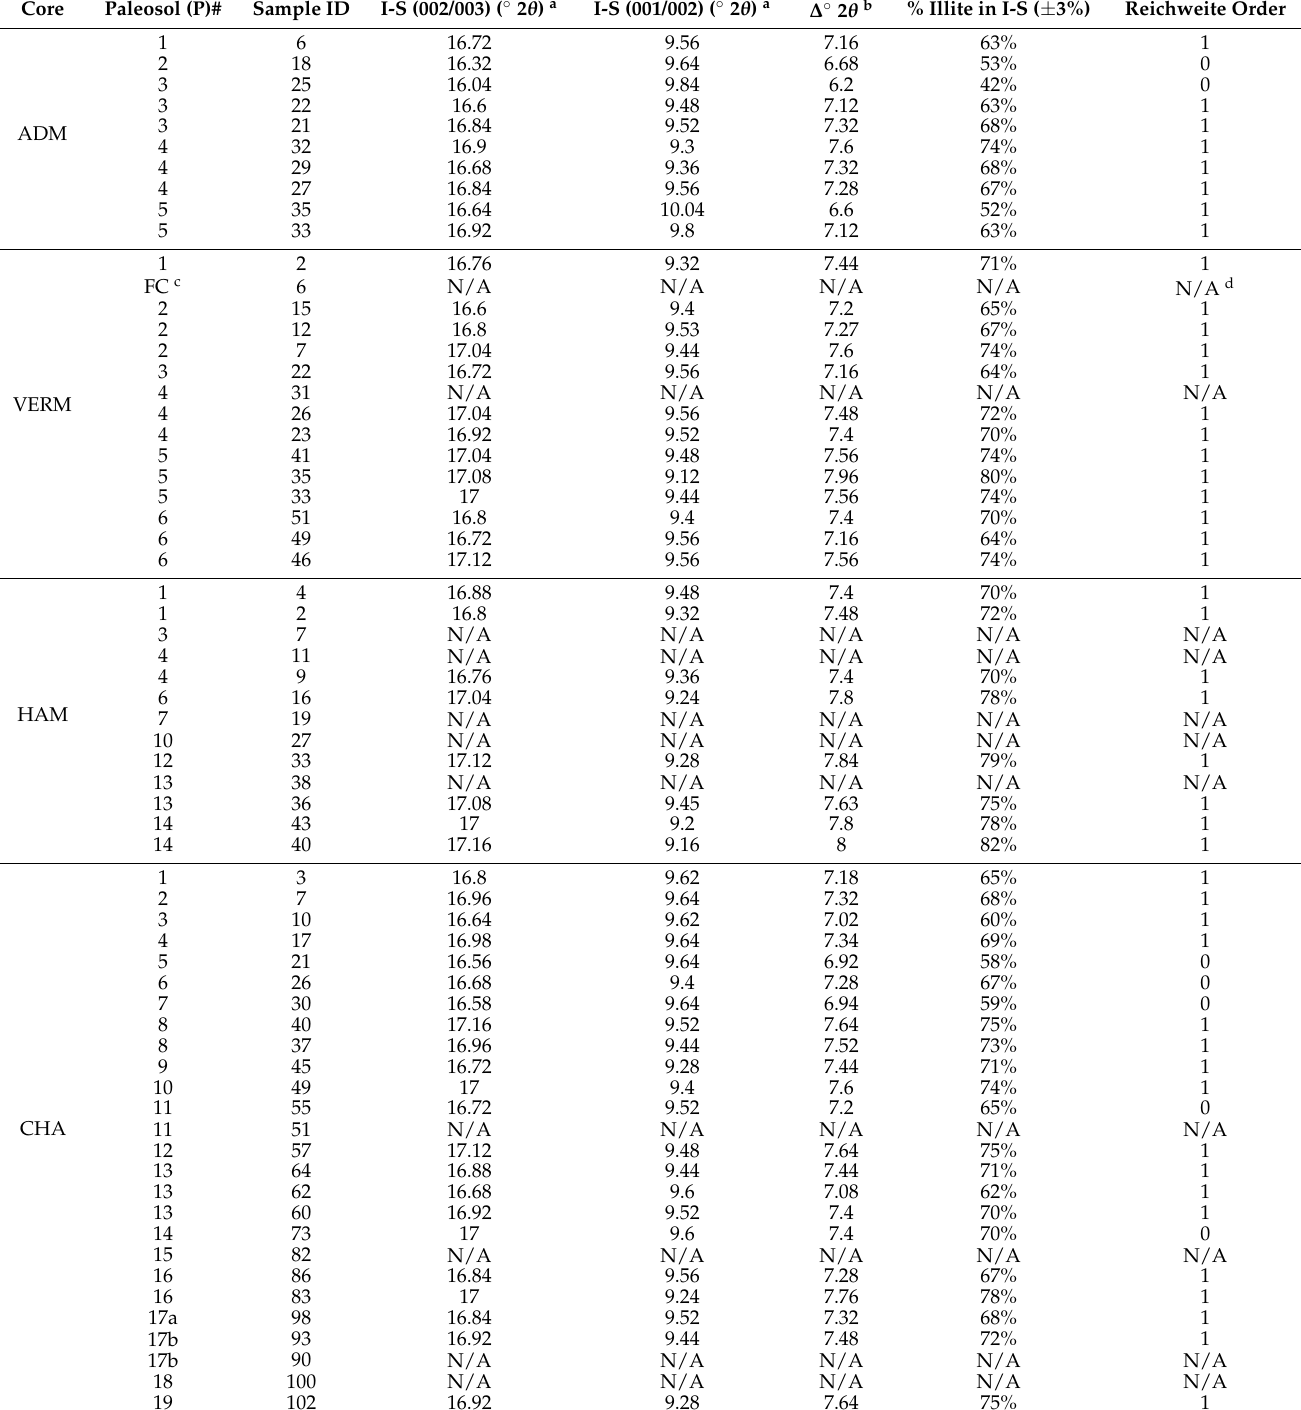
Table 2. Results of XRD analysis the <2.0 µ m clay-sized fraction of Illinois Basin paleosol